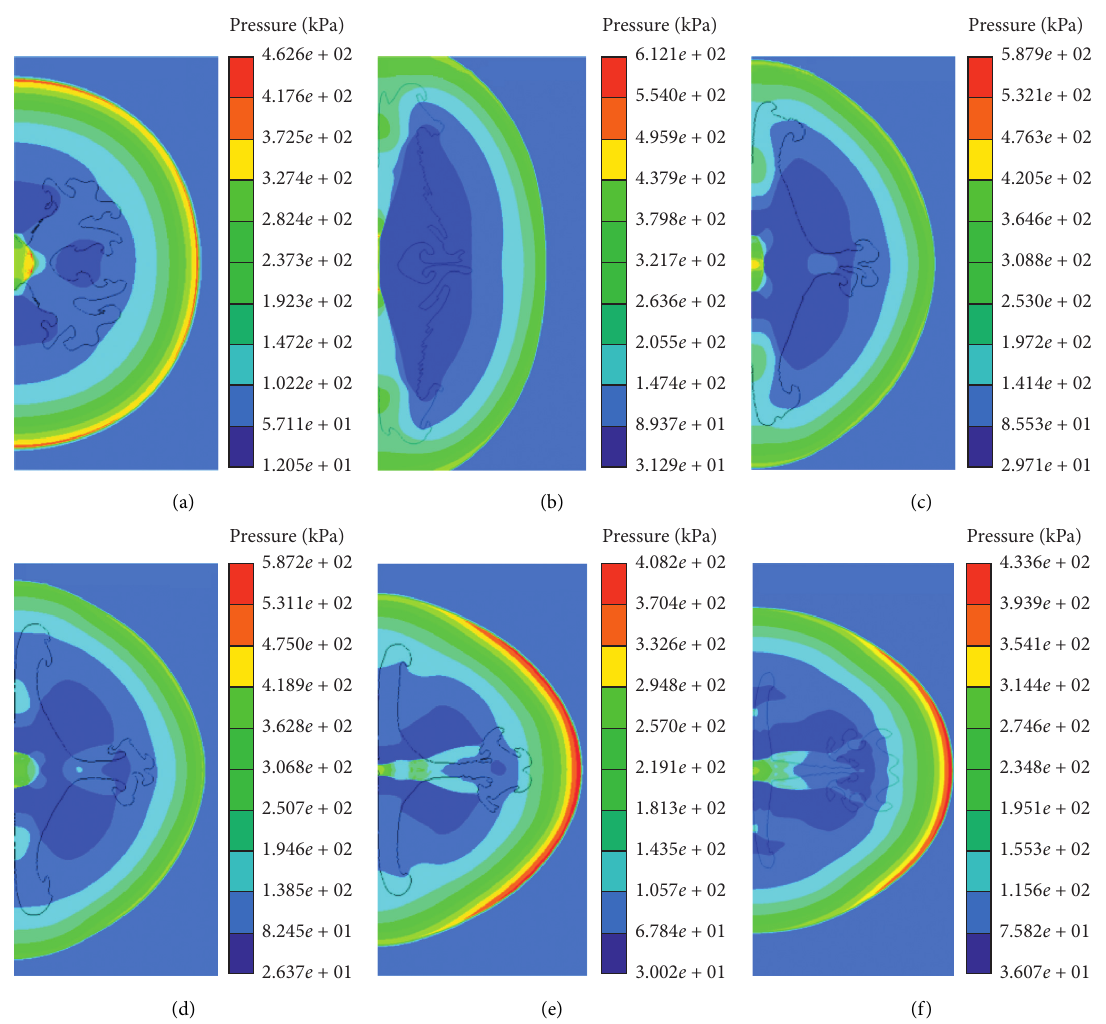
Figure 5: Pressure contours from spherical charge and cylindrical explosives at t � 1.5 ms. (a) Spherical. (b) Cylindrical, L / D � 0.2. (c) Cylindrical, L / D � 0.6. (d) Cylindrical, L / D � 1.0. (e) Cylindrical, L / D � 2.0. (f) Cylindrical, L / D �